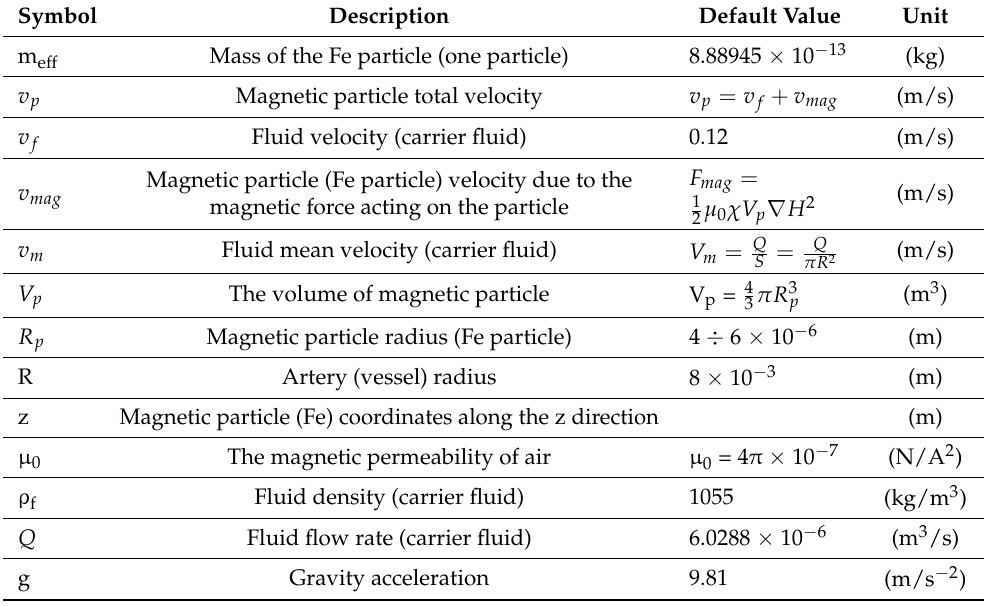
Table 8. Parameters used for magnetic and drag force